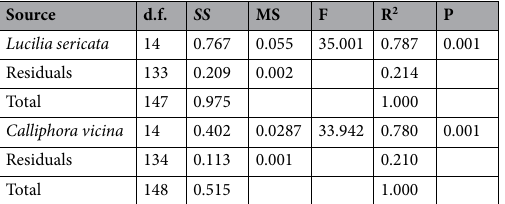
Table 2. PERMANOVA results testing Lucilia sericata and Calliphora vicina hydrocarbon profiles based on Bray-Curtis dissimilarity among aged puparial cases from 1–8 weeks and 3–9 months.